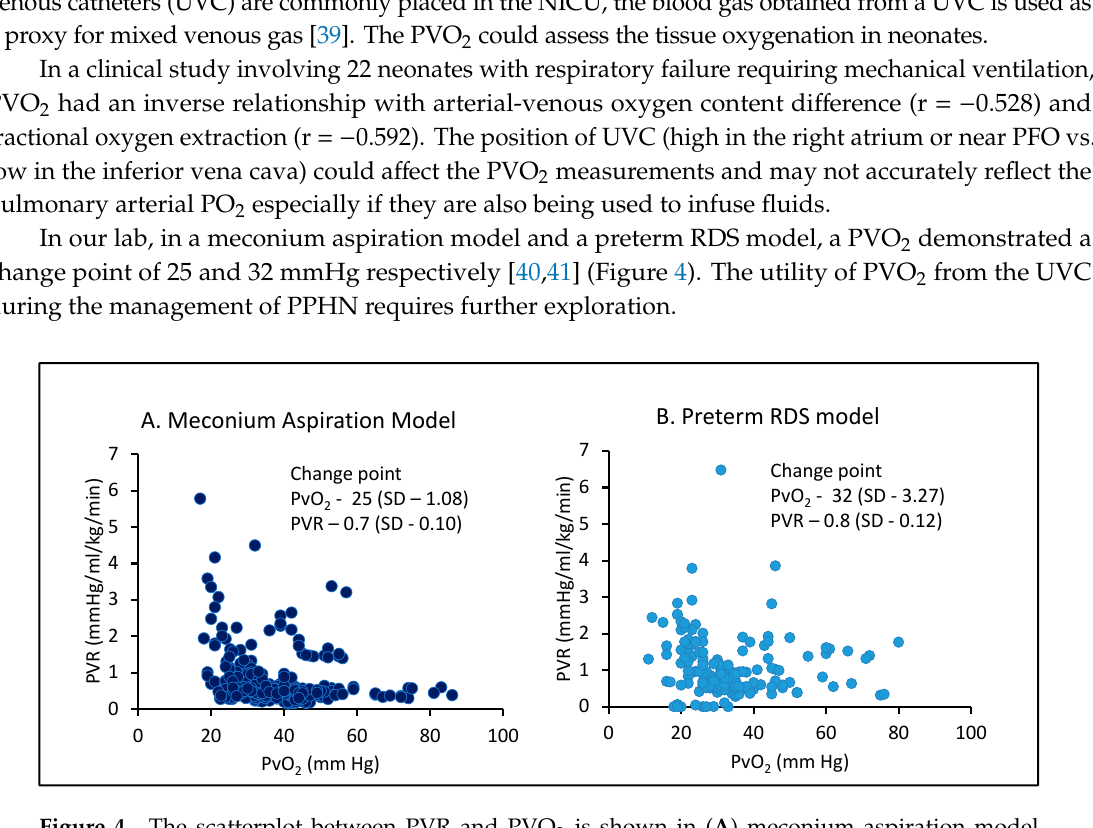
Figure 4. The scatterplot between PVR and PVO 2 is shown in ( A ) meconium aspiration model and ( B ) preterm RDS model. The PVO 2 was obtained from the main pulmonary artery blood gas. The MCMC model using SAS 9.4 (NC) estimated change point. Copyright MR/PC/SL.